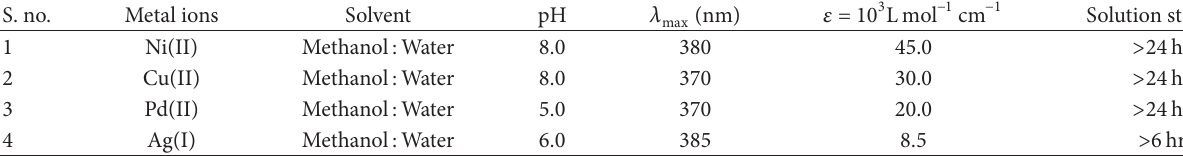
T 1: Quantitative spectrophotometric data of color reaction of PPS with metal ions. S.